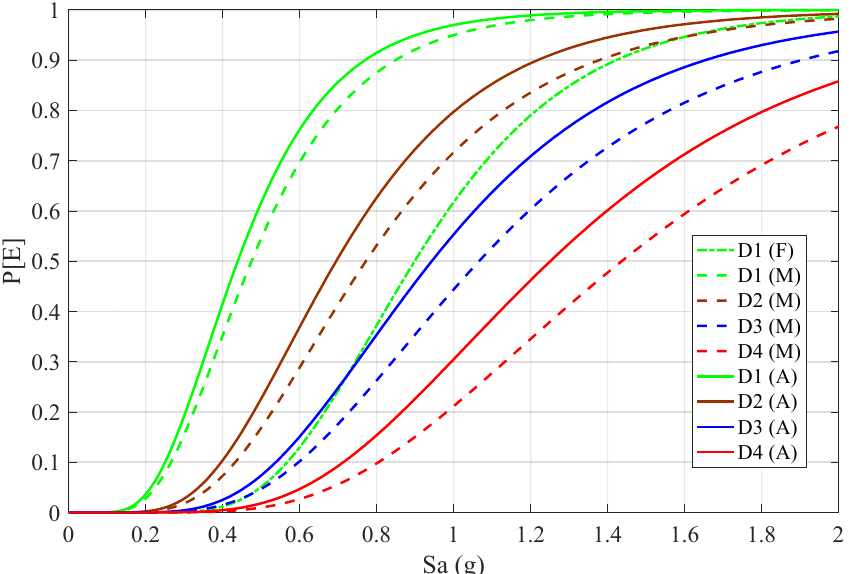
Figure 11. Comparative plot of fragility functions for foreshock, foreshock–mainshock, and foreshock–mainshock–aftershock scenarios. F, M, and A within the parentheses indicate foreshock, foreshock–mainshock, and foreshock–mainshock–aftershock events.